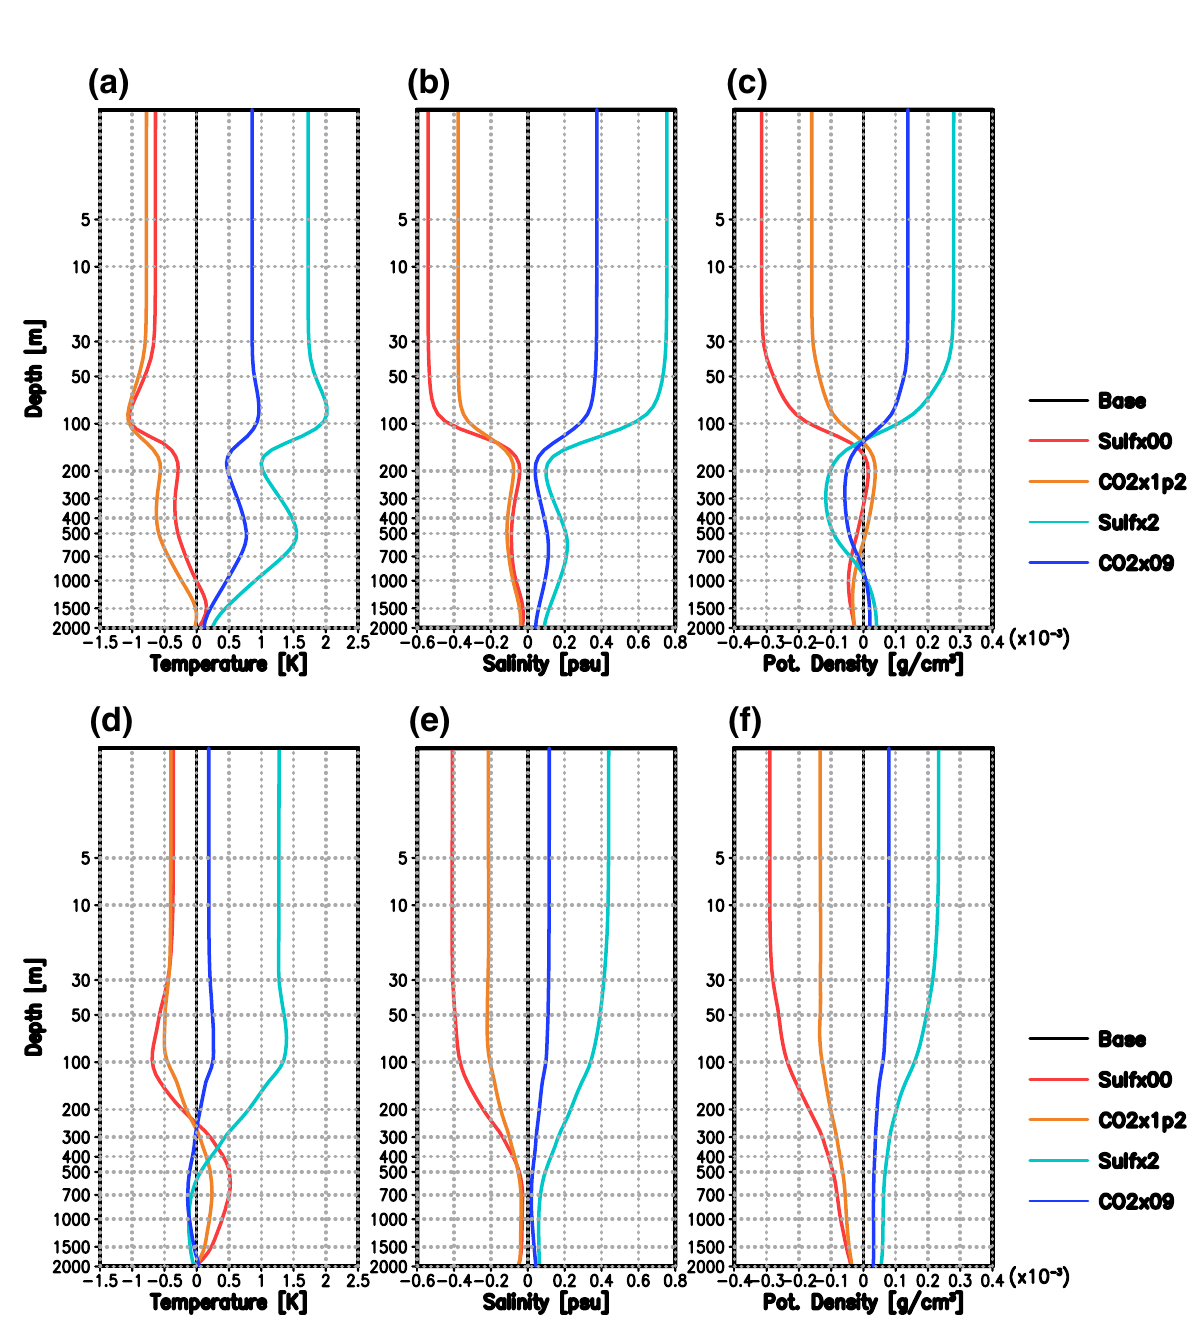
Figure 4. Anomalies of annual mean vertical profiles of ( a,d ) potential ocean temperature (K), ( b,e ) salinity (psu), and ( c,f ) potential density (g cm –3 ) averaged in the ( a–c ) NAWH region (20°–40°E, 40°–60°N) and ( d–f ) Labrador Sea (52°–60°E, 55°–63°N) for each experiment from the base